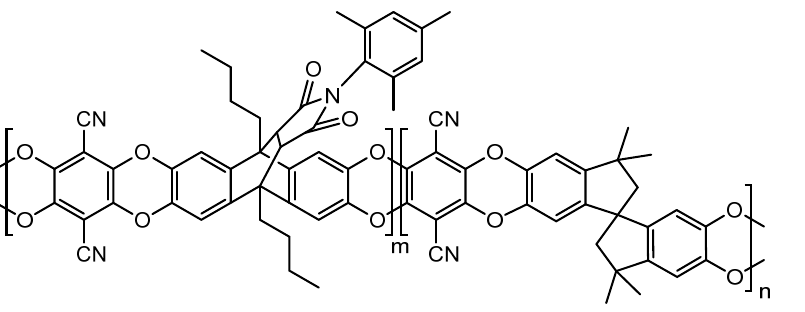
Figure 1. Anthracene maleimide comonomer structure.